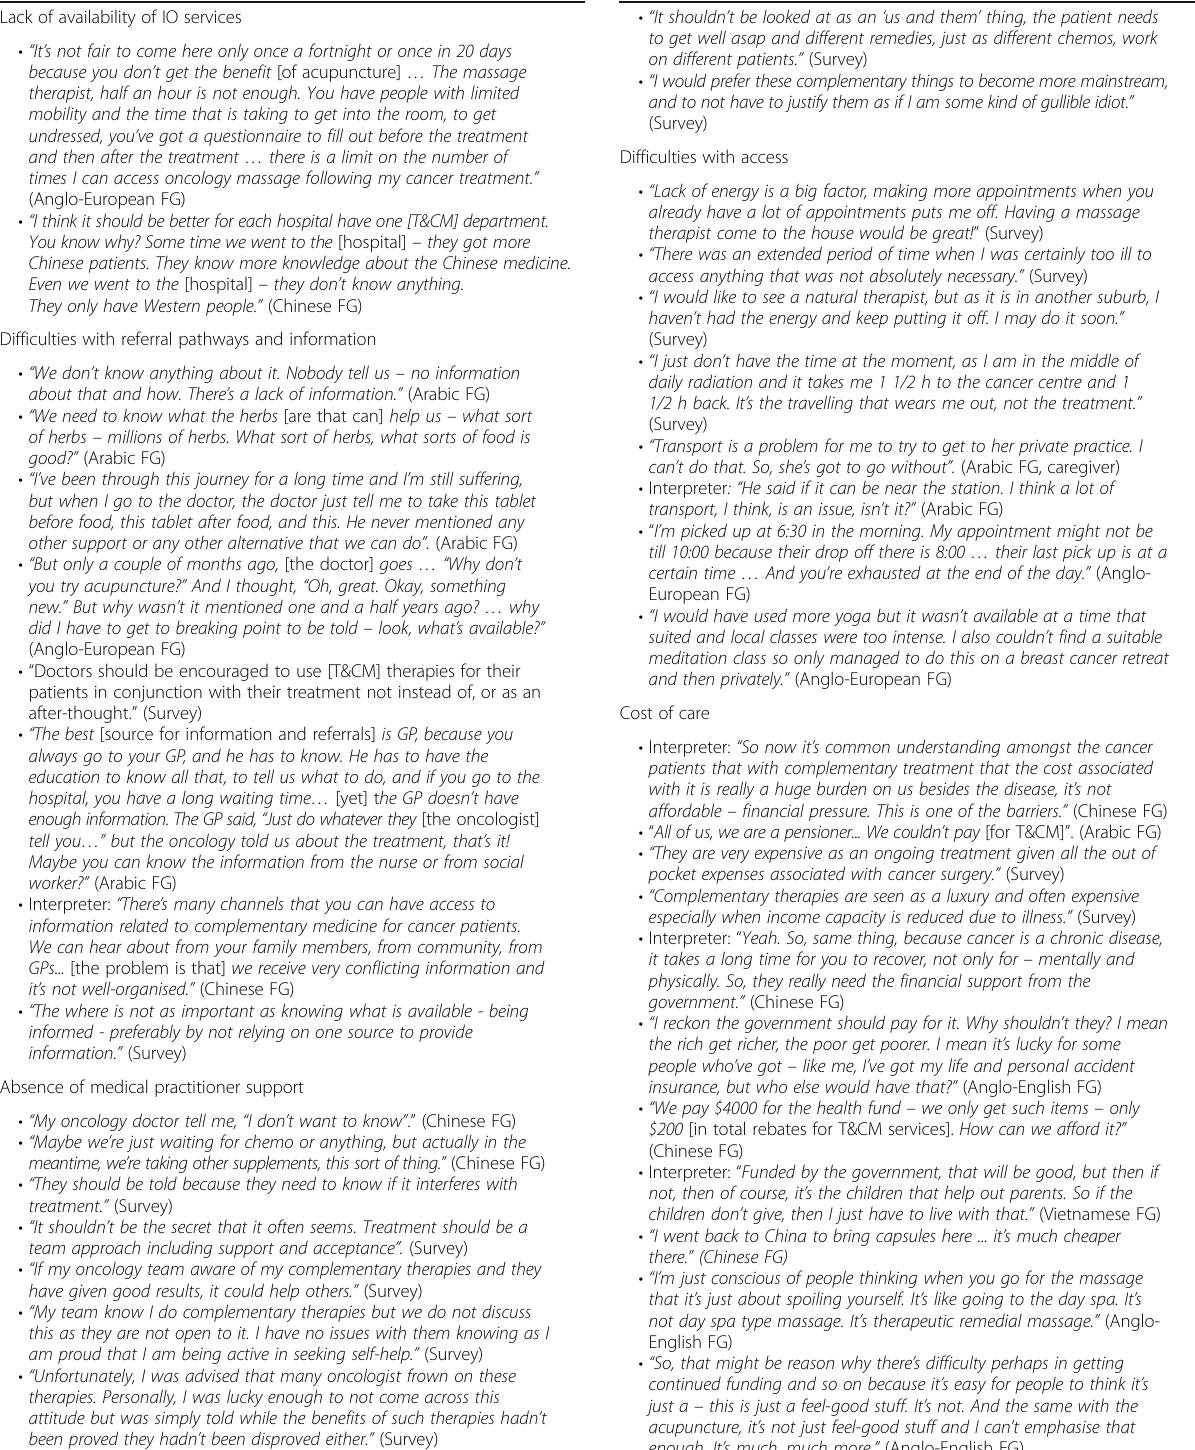
Table 5 THEME 2 - Barriers and unmet needs